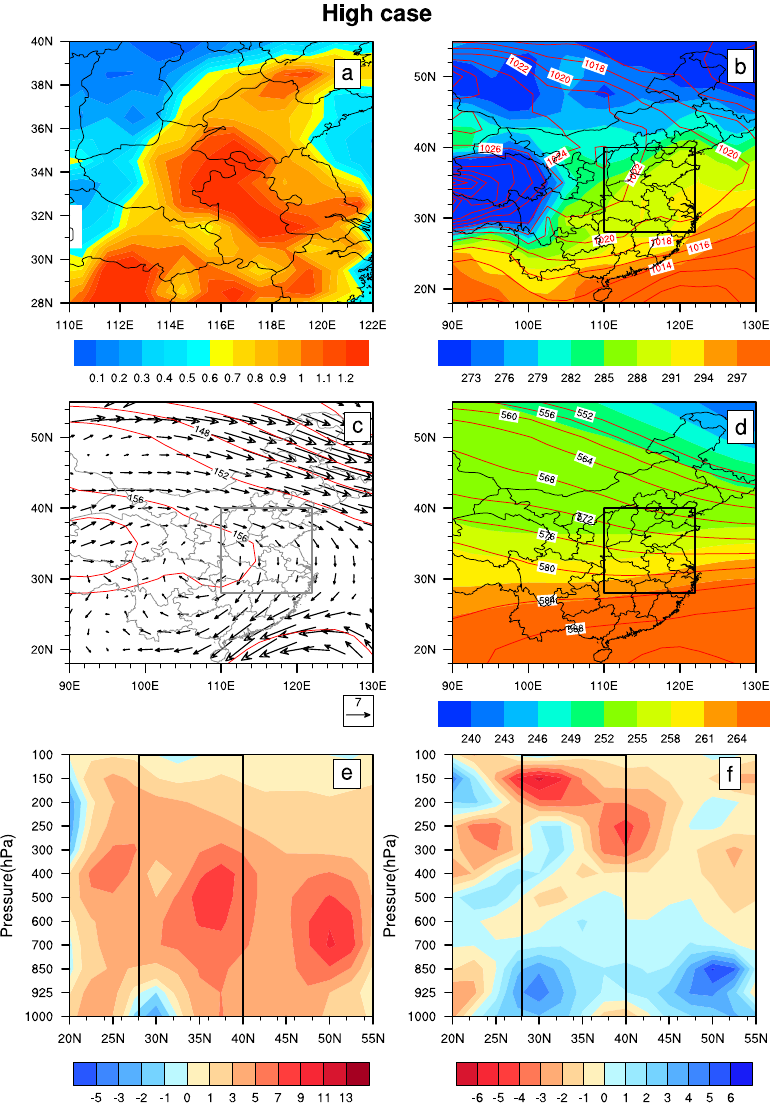
Figure 5. A typical polluted episode (28 to 31 October 2006). (a) The distribution of AOD over eastern China, (b) sea level pressure (red line) and temperature (colour shades) fields, (c) 850hPa wind and geopotential height (red line) fields, (d) 500hPa temperature (colour shades) and geopotential height (red line) fields, (e) height–latitude cross-sections of vertical velocity (10 − 2 Pas − 1 ), and (f) divergence of winds (10 − 6 s − 1 ) averaged from longitude of 110–122 ◦ E. Note: black rectangular region represents eastern China (110–122 ◦ E, 28–40 ◦